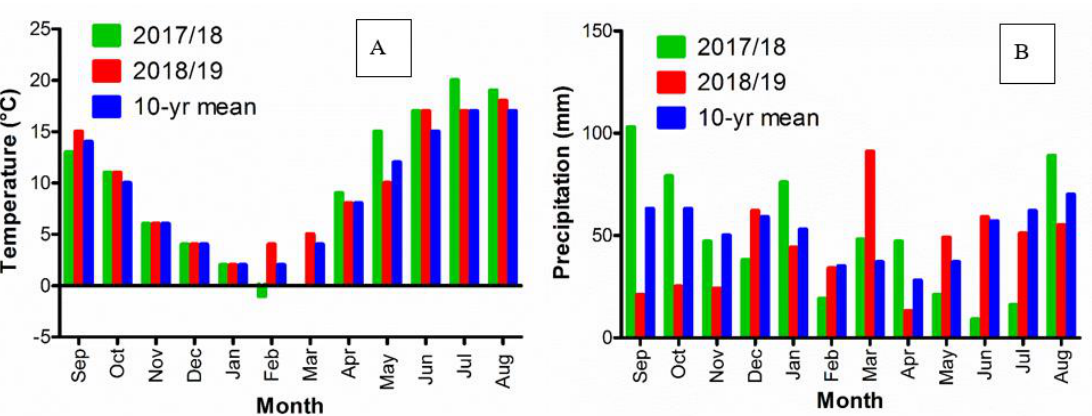
Figure 1. Weather data for 2017 / 18, 2018 / 19, and 10 yr means from 2011 to 2020. ( A ) Monthly average air temperature and ( B ) precipitation.